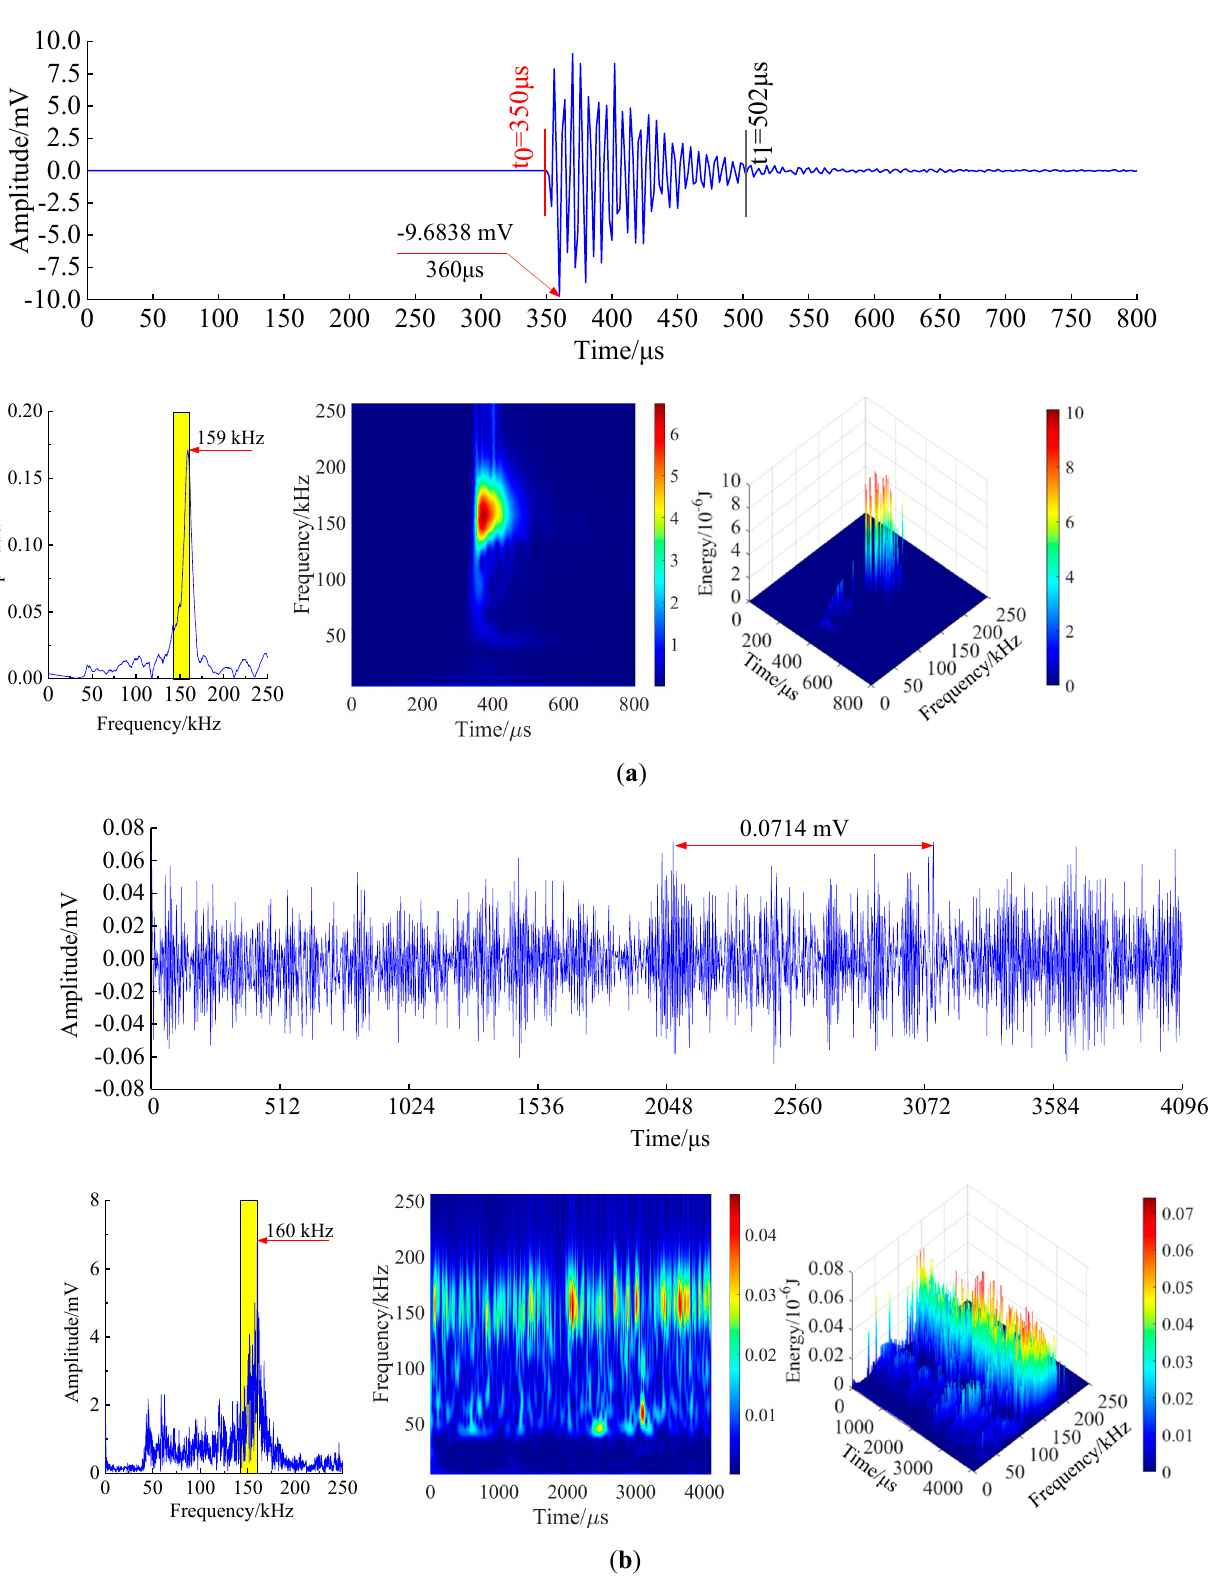
Figure 12. Time frequency diagram of two AE waveforms corresponds to FFT, WT and HHT. ( a ): HW1; ( b ): HW2.